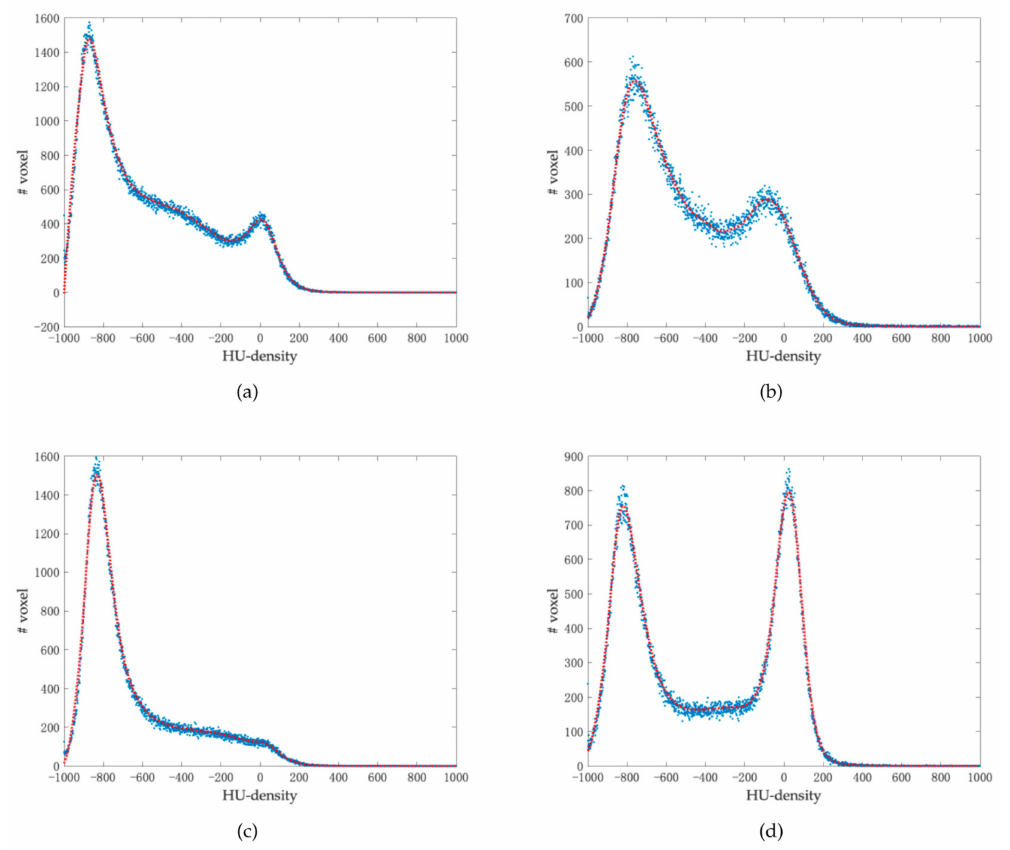
Figure 3. ( a – d ) Examples of post-processed HU-density